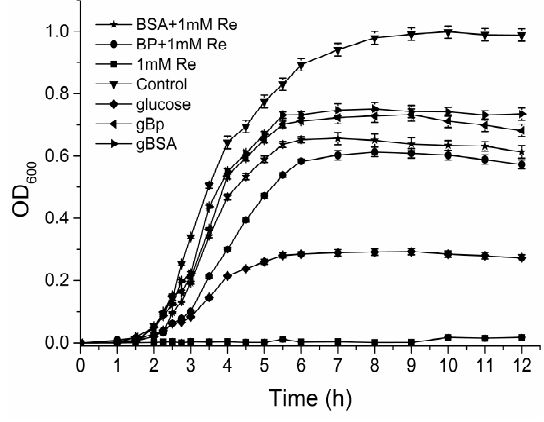
Figure 2. Effects of resveratrol (Re) on the growth curve of EC in different environments.